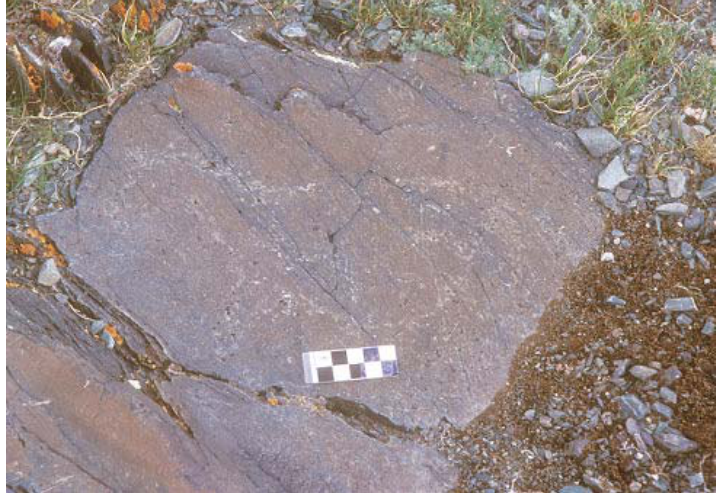
Figure 13. Faint image of a horse on a flat boulder. Pre-Bronze Age. Tsagaan Salaa IV.